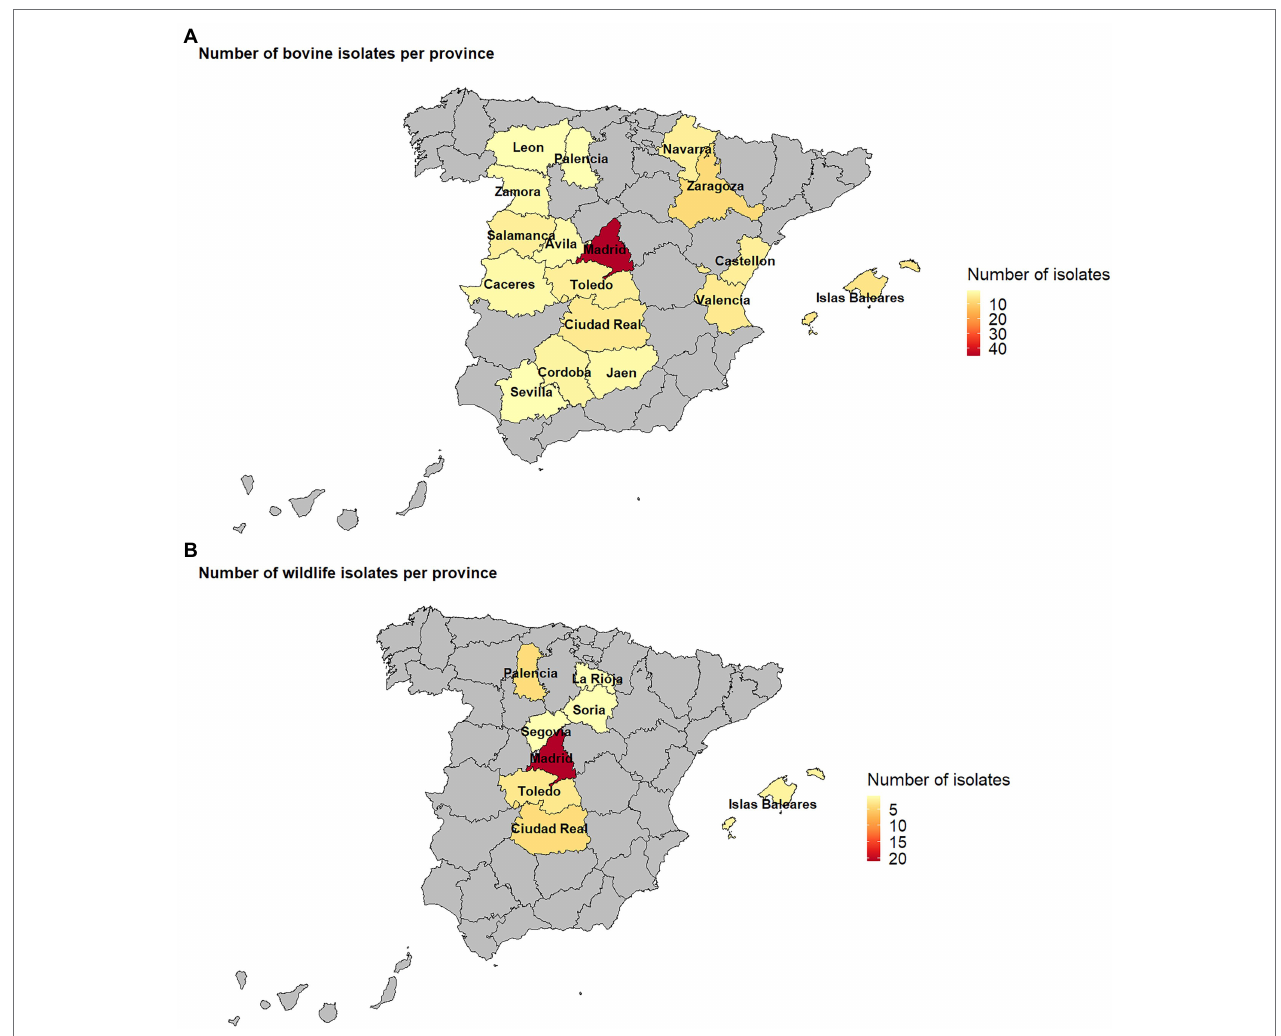
FIGURE 1 | Map of the number of M. bovis SB0339 isolates recovered from cattle (A) and wildlife (B) per province included in the